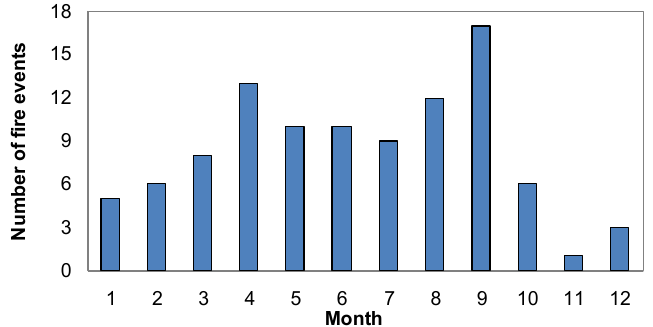
Figure 8. Number of fire events in every month between 2001 and 2011 at the WIMO1 site.